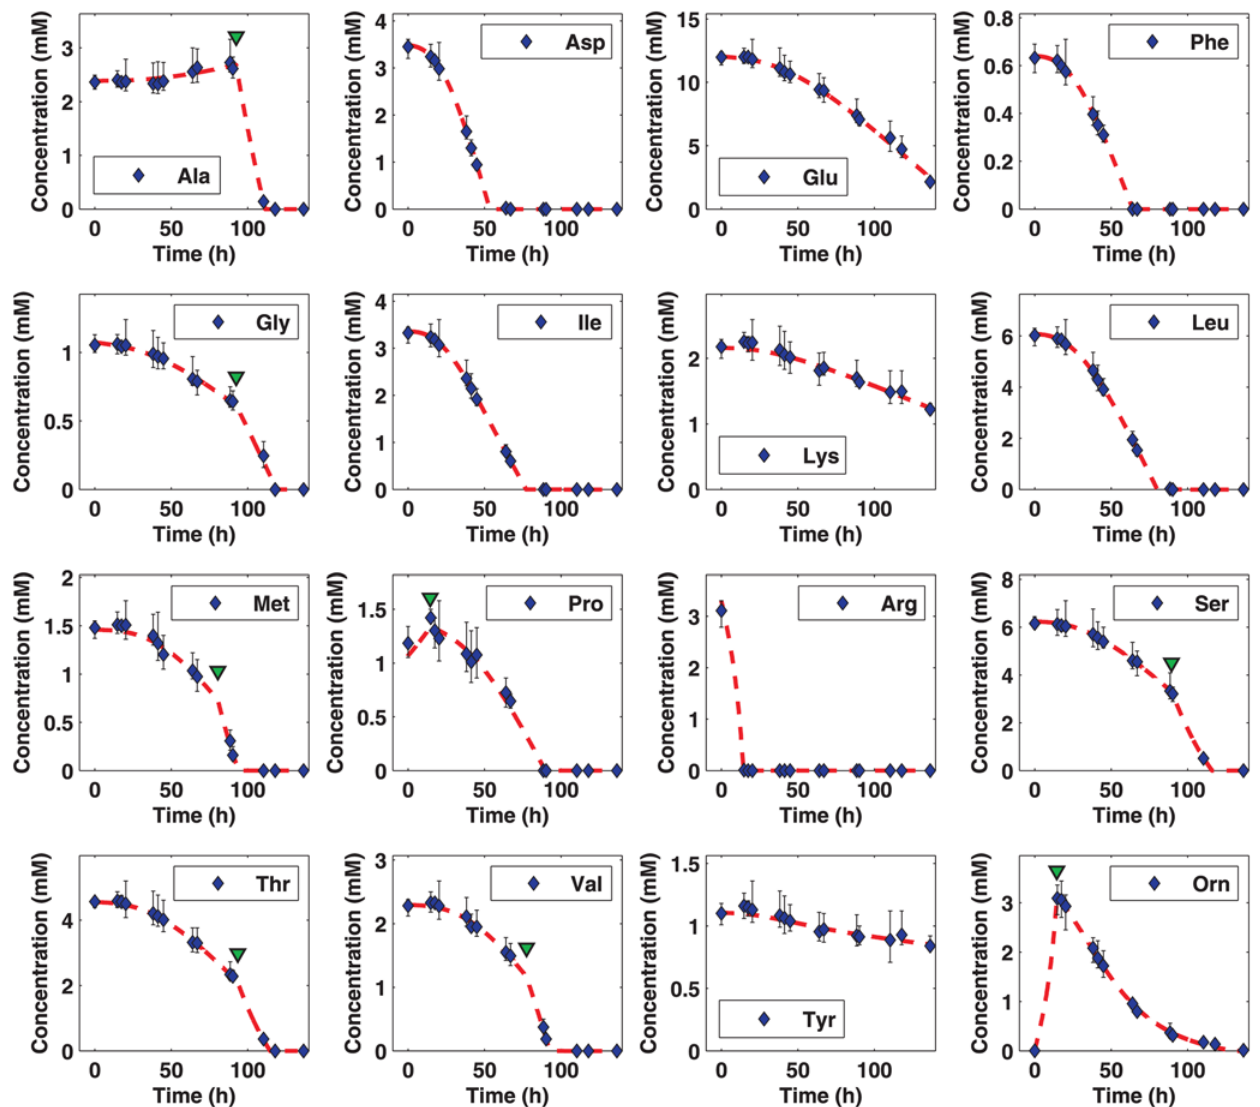
Figure 2. Nutrient consumption and production data from aerobically grown cells. Experimental data are shown using diamonds (average) with error bars provided. Model simulations are illustrated using red broken curves. The transport patterns of several metabolites qualitatively change during growth. For example, alanine and ornithine switch from production to consumption. For such metabolites, the piecewise Equation (3) was used to model utilization, and the corresponding t i , b parameter value, which represents a point near where the qualitative change occurs, is indicated with an inverted green triangle.